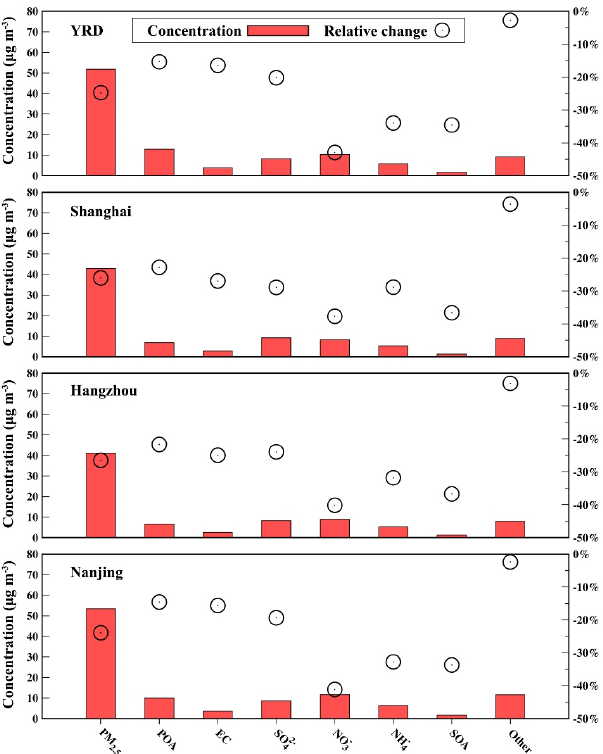
Figure 3. Predicted PM 2 . 5 and its major components in case 2 (red histogram corresponding to left y axis) and the relative change (cir- cle corresponding to right y axis) from 23 January to 28 Febru- ary 2020 in the YRD and Shanghai, Hangzhou, and Nanjing. Here the relative change means the relative change in concentration be- tween case 1 and case 2, which is calculated as (case 2 − case 1) / case 1.